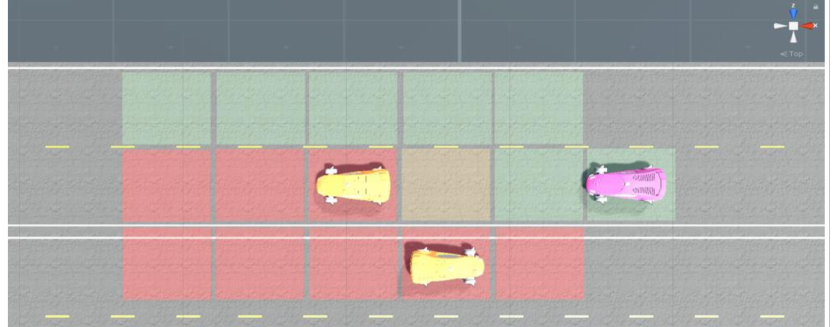
Figure 8. Visualize car trajectory.